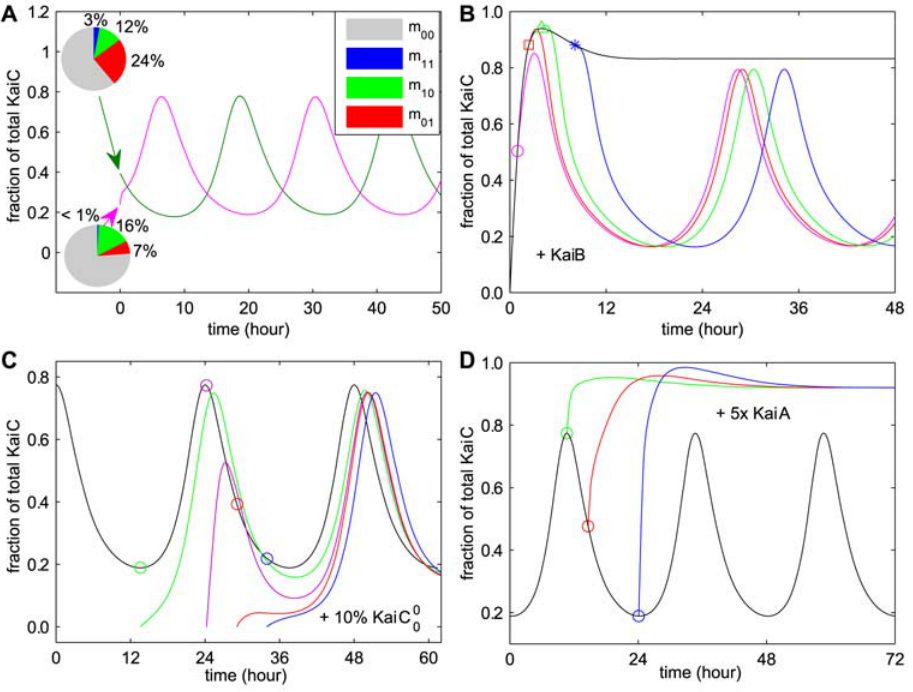
Figure 8. Further examination of the model by recent experimental data. (A) The distribution of KaiC phosphoforms determines the phase of KaiC phosphorylation. The KaiC sample enriched in m 10 (monomer with T432 phosphorylated only) is obtained as follows: simulating binary KaiA and unphosphorylated KaiC reaction for 3 hours and then removing KaiA; then adding KaiB for KaiB-KaiC binary reaction for another 3 hours. The m 01 (monomer with S431 phosphorylated only) enriched KaiC is prepared by mixing KaiA and KaiC for 20 hours, removing KaiA, and allowing KaiC dephosphorylate for 2.4 hours. (B) Standard amount of KaiB is introduced at different time points during KaiA-KaiC reaction process. (C) Extra unphosphorylated KaiC with 10% standard concentration of KaiC is introduced at various circadian time points in KaiC phosphorylation. Colored profiles (not black) show the phosphorylation dynamics for the added KaiC samples after their introductions. (D) KaiC phosphorylation profiles with 5 6 standard KaiA added at different circadian time